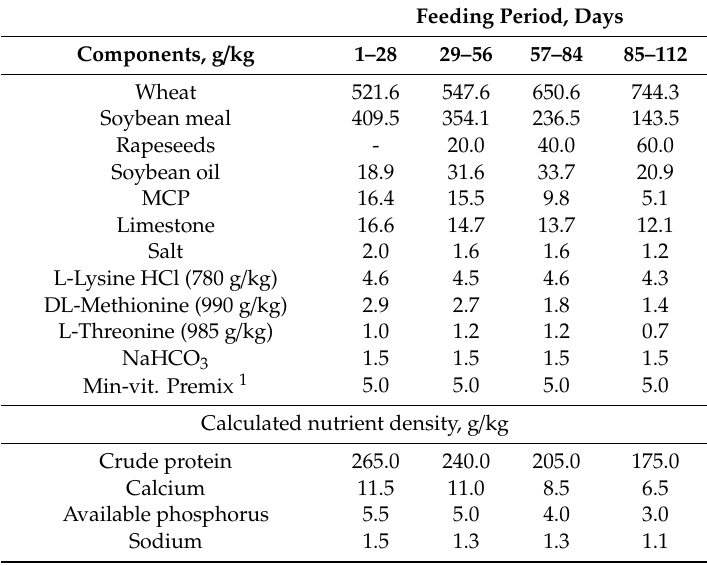
Table 1. Composition and nutrient density of